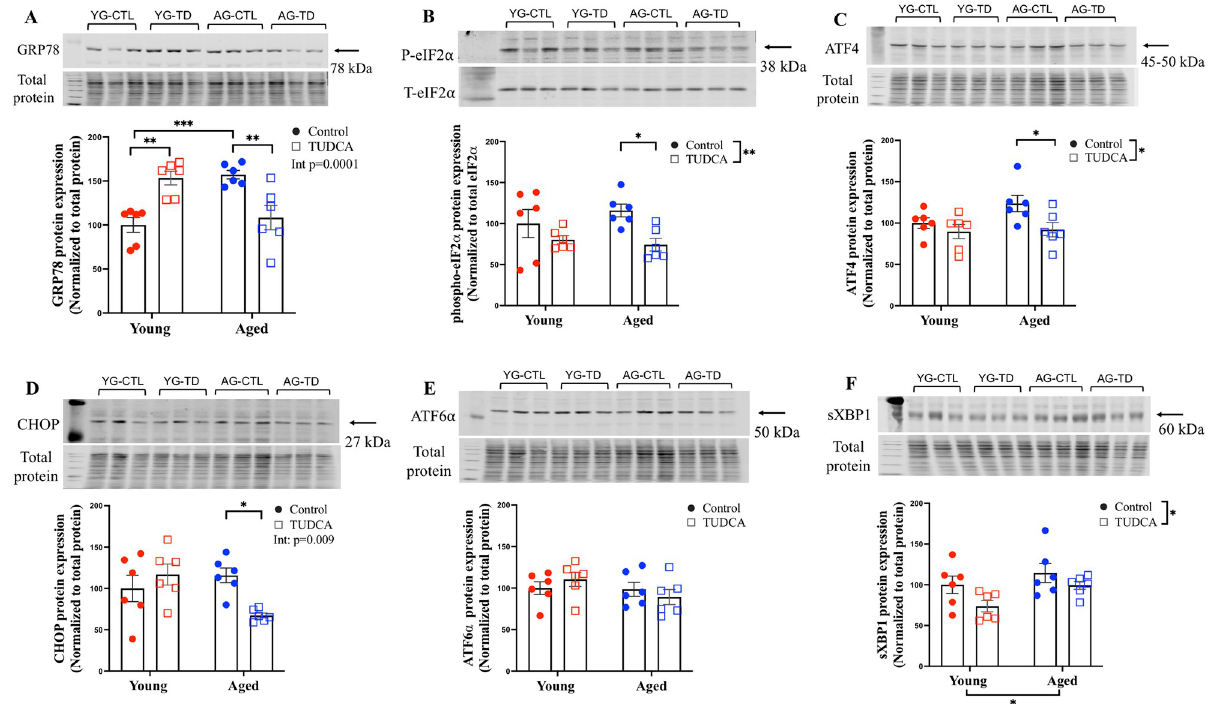
Fig 2. Male labyrinth zone. Western blot analysis of male offspring labyrinth zone (A) GRP78, (B) phospho-eIF2 α , (C) ATF-4, (D) CHOP, (E) ATF- 6 α , and (F) sXBP-1 normalized to total protein (except phospho-eIF2 α normalized to Total eIF2 α ) in male placenta labyrinth zone of young (3–4 months; in red) and aged control dams (9–9.5 months; in blue) with (open squares) or without (closed circles) TUDCA-treatment on gestational day 20. Data are presented as mean ± SEM and expressed as percentage of control (i.e., the mean of the young control dams); analyzed by two-way ANOVA with Sidak’s multiple comparisons post-hoc test; * p < 0.05, ** p < 0.01, *** p < 0.001; n = 6/group. YG-CTL = Young control dams; YG-TD = Young TUDCA-treated dams; AG-CTL = Aged control dams; AG-TD = Aged TUDCA-treated dams.